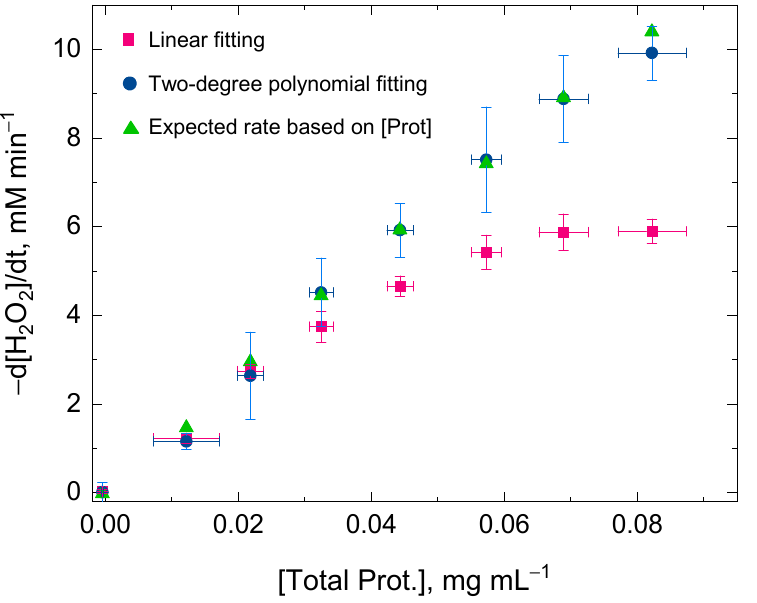
Figure 2. Ratio between the total protein concentration extracted from wheat flag leaves and the initial rate of the H 2 O 2 decomposition by catalase present in the protein extraction. The values for the initial rates were obtained after linear fitting (red squares) and 2-degree polynomial fitting (blue circles) of the experimental data points recorded in the time domain 0 ≤ t ≤ 2 min. The green triangles show the expected values for the initial rate based on the measured protein concentration. The discrepancy between the two fitting procedures was more prominent as the total protein concentration increased in the reaction mixture. A better linear ratio between the initial rate (below 10 mM min − 1 ) and the protein concentration was determined when using a 2-degree polynomial fitting. A number of nine replicates using the proposed protocol (Experiment I) were average for each of the eight sample fractions. The total protein concentration for the sample fractions in the reaction mixture was kept below 0.1 mg mL − 1 and the initial [H 2 O 2 ] was always 25 mM. The H 2 O 2 decomposition rate was followed at 240 nm in a multimodal plate reader.